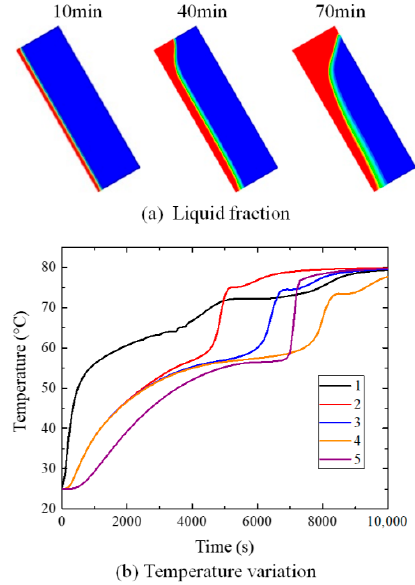
Figure 10. The melting process of paraffin at 30°. ( a ) Liquid fraction; ( b ) temperature variation.